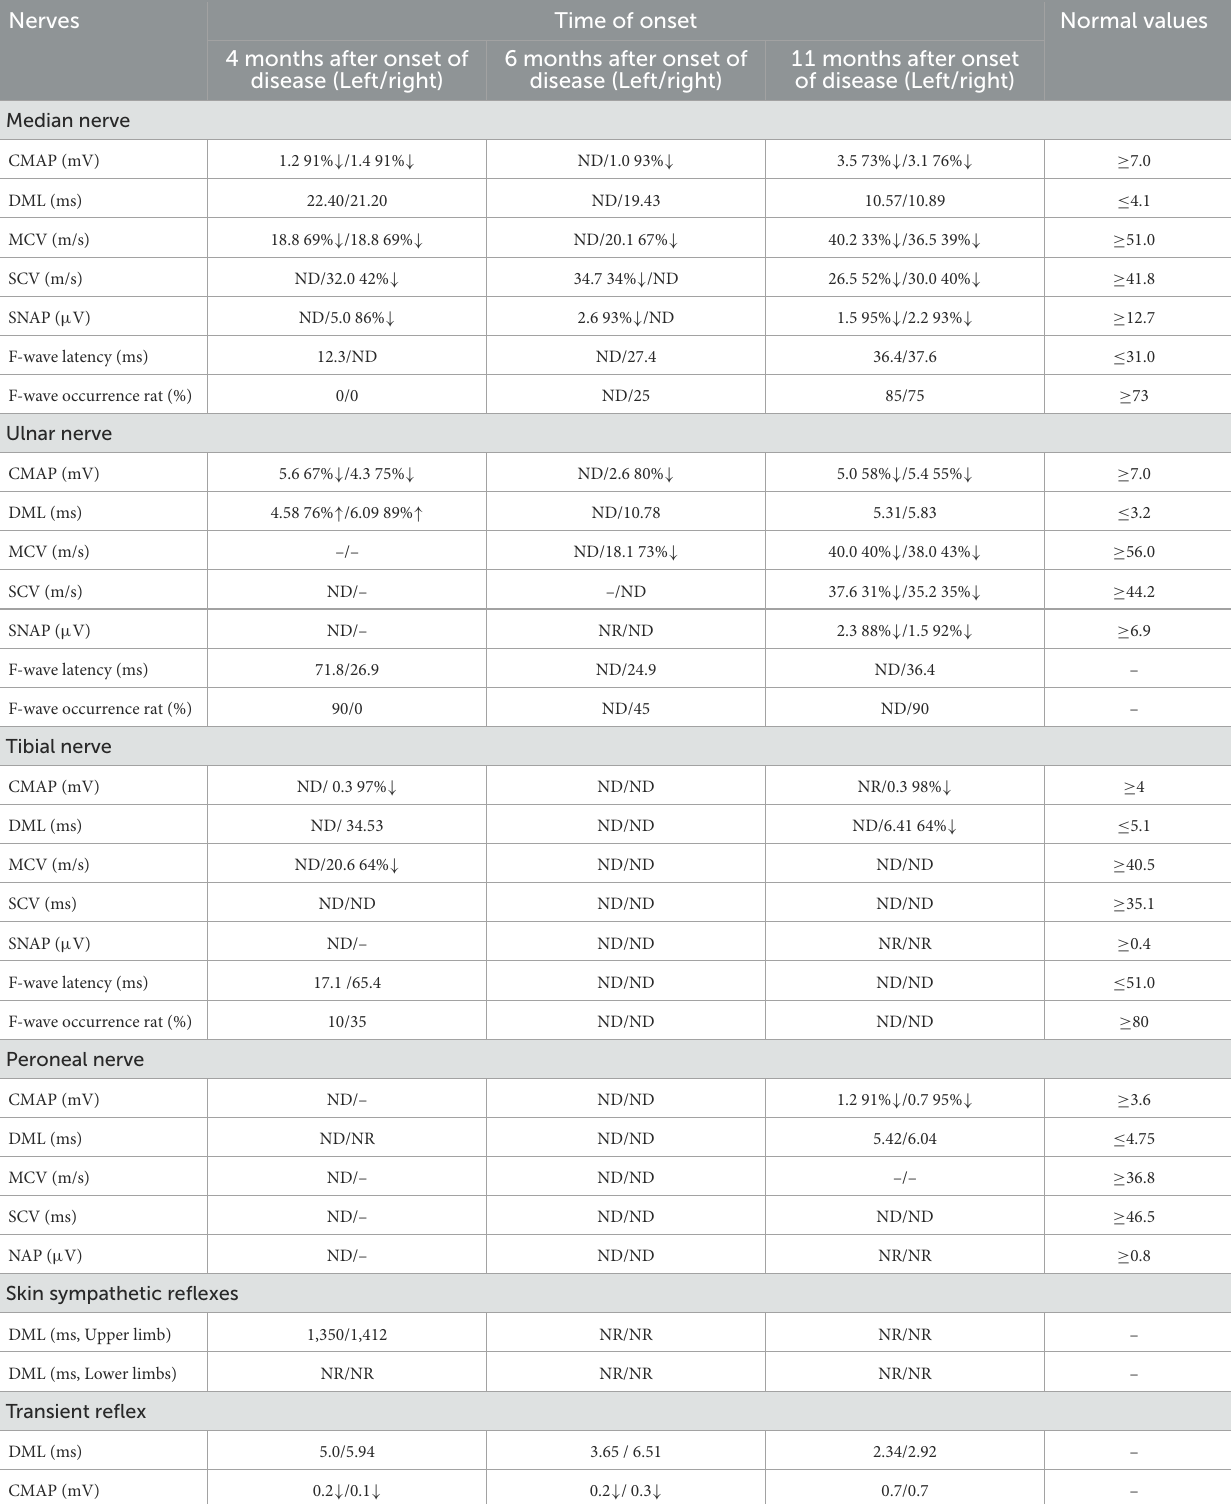
TABLE 2 Results of nerve conduction study and F-wave of the anti-contaction-1 IgG4 antibody associated autoimmune nodopathies. Nerves Time of onset Normal values 4 months after onset of 6 months after onset of 11 months after onset disease (Left/right) disease (Left/right) of disease